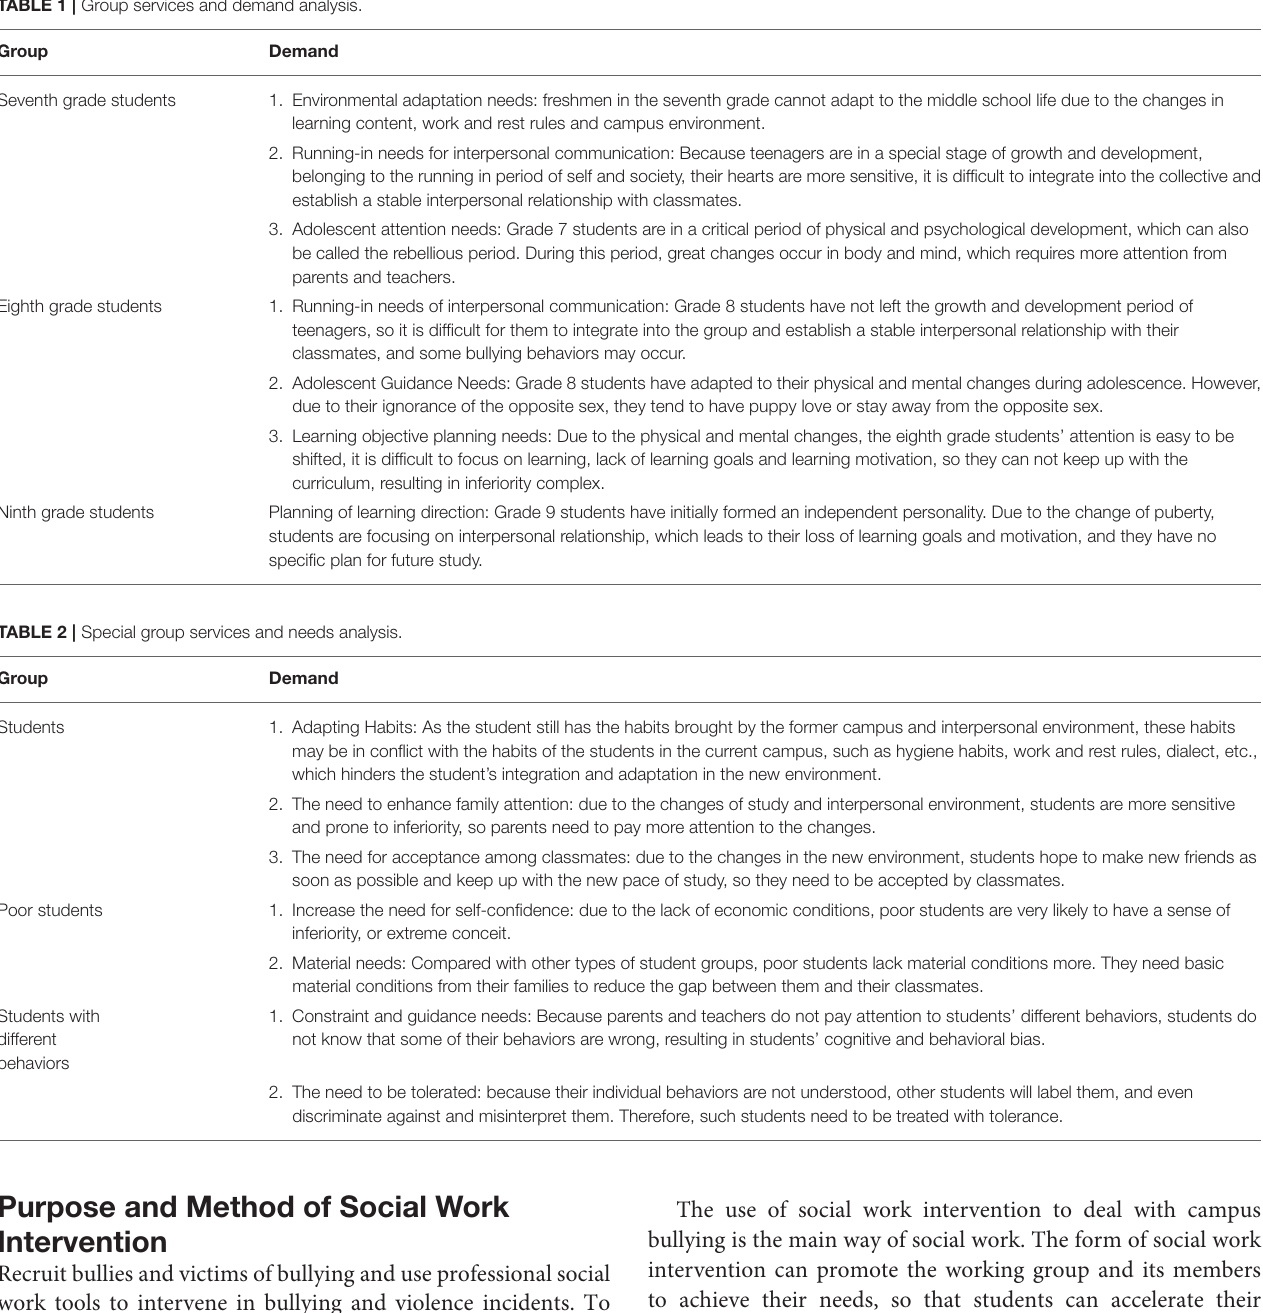
TABLE 1 | Group services and demand analysis.